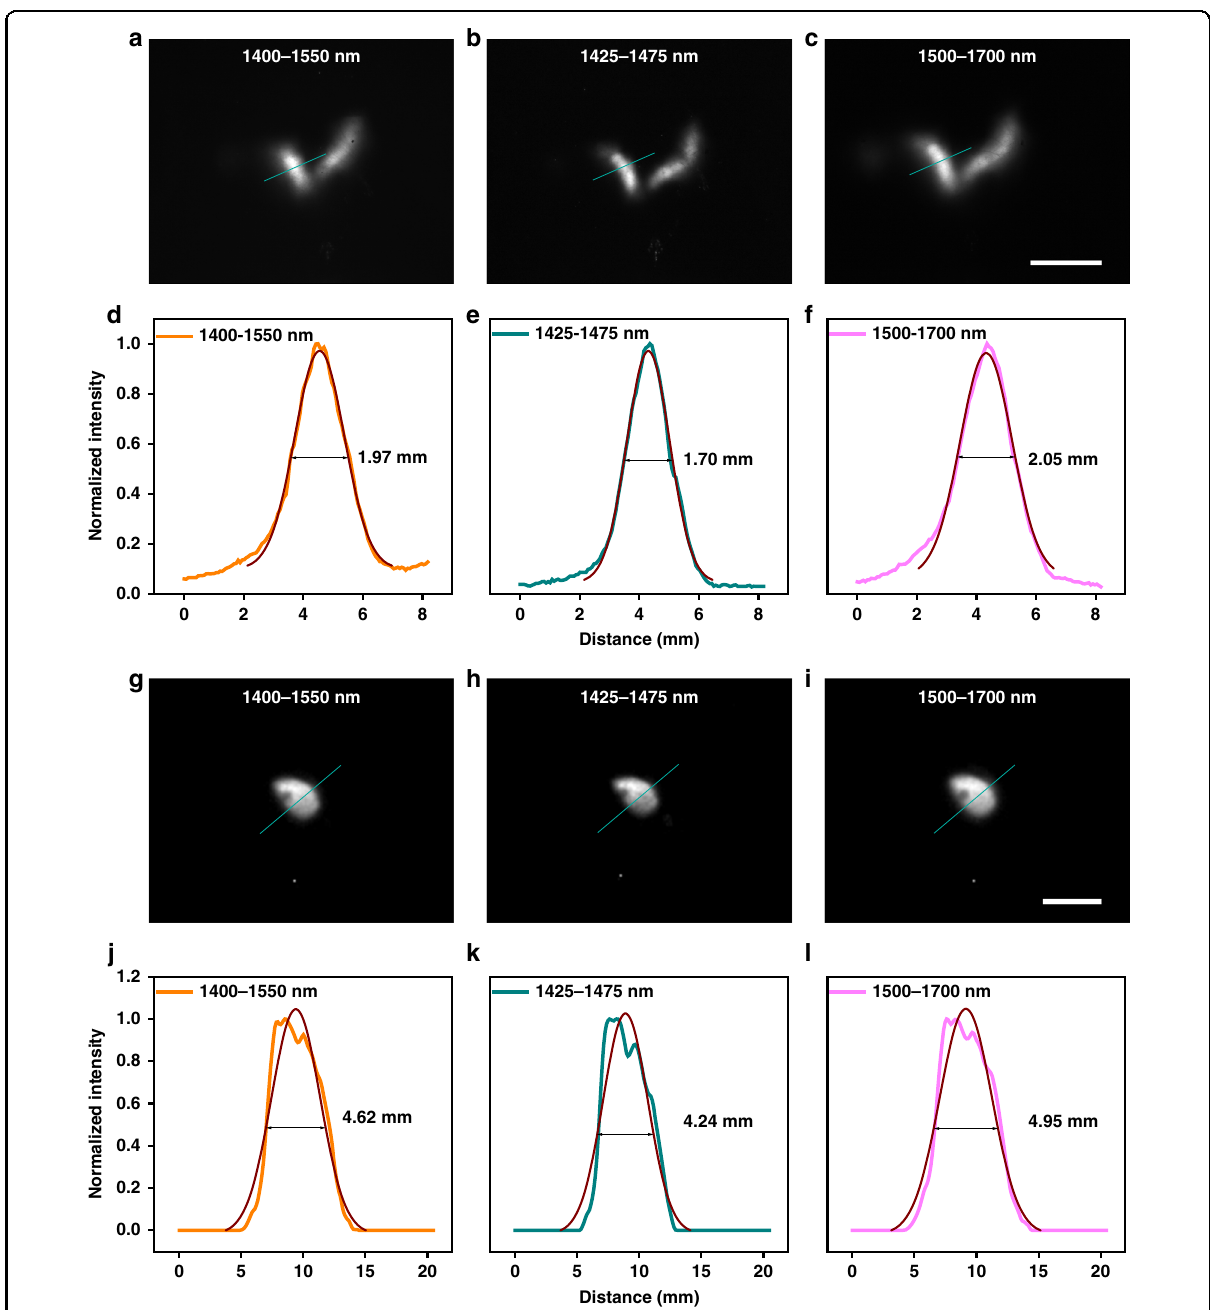
Fig. 6 Functional in vivo fl uorescence imaging of mice in 1400 – 1550, 1425 – 1475, and 1500 – 1700nm. The uterine imaging of the